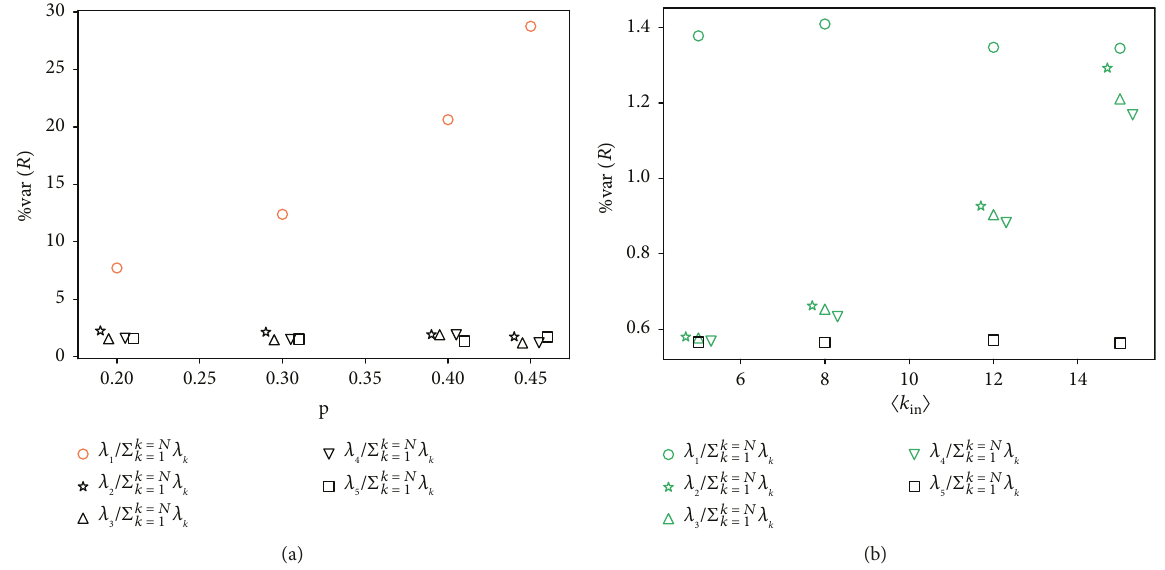
Figure 12: Percentage of the total explained variance of correlation matrix %var R , (29), for each of the fi rst fi ve components λ R as a function of the edge probability, p , for an Erdös-Rényi of size N = 50 (a), and intracluster degree, k in , for a Newman modular network of size N = 256 and k total = 16 (b). Both networks enable a factor model as a good descriptor of the outcome. Selected signi fi cant number of components are highlighted in orange and green colors, for ER and Newman modular networks, respectively. As nodes become more connected and communities more delimited, factor model moves from mirroring a noisy identity matrix to be a clear indicator of the correlation structure. First component (circular orange marker) increases as p does so, strengthening the validity of a 1-factor model (a), while second to fourth components (circular, starry, and triangular green markers) increase as k in does so. Hence, an increase in modularity reinforces the validity of a 4-factor model (b). Parameters are set as in Figure 6, constraining the values to lay within the metric stable state regime.